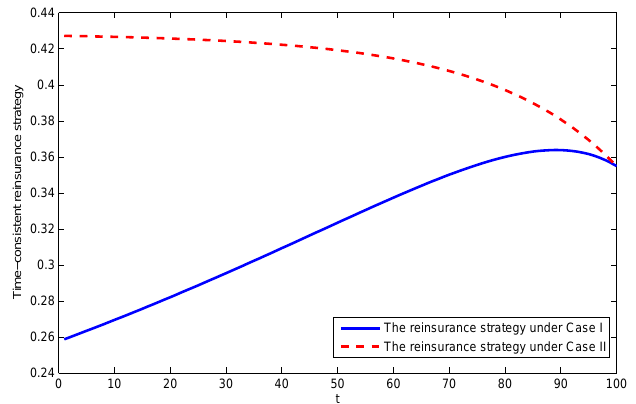
Figure 5. Time-consistent reinsurance strategy under the variance value principle ( α = 0.4 and T = 100).